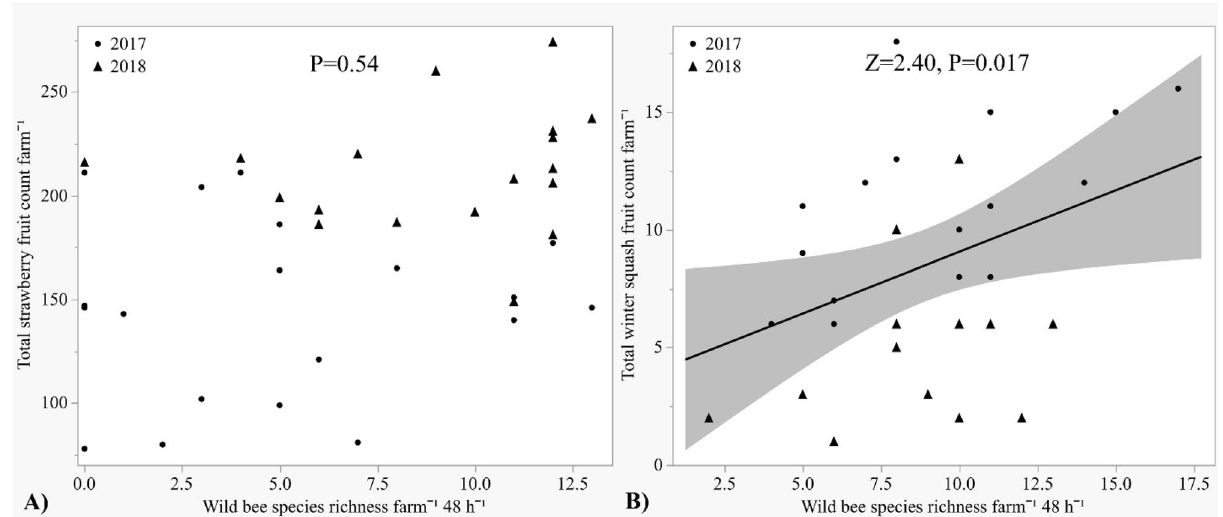
Figure 5. Total strawberry and winter squash fruit count analyzed by wild bee species richness: ▲ = 2017, = 2018. ( A ) Strawberry fruit count, ( B ) Winter squash fruit ●